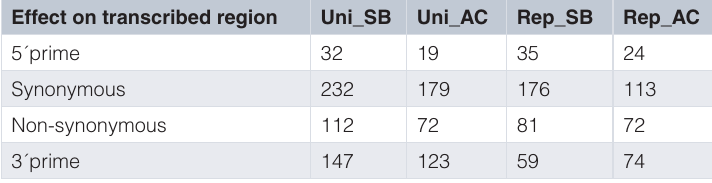
Supplemental Table S7. Predicted effect of SNP-candidates differing in frequency between charr